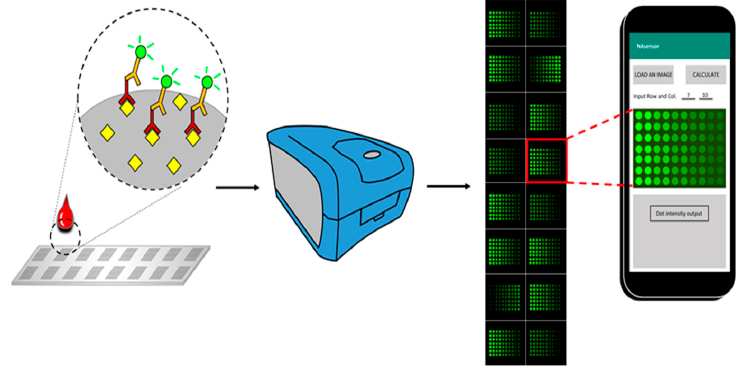
Figure 1. Schematic diagram of the smartphone-based imaging analysis for the fluorescent-labeled autoantibody array. Antigens were printed on the surface of an array slide, and the slide can be divided into multiple fields according to the printing design. A whole field contains hundreds of different antigen spots that are capable of detecting abundant types of corresponding autoantibodies in the serum, with each spot representing one type of antigen. Cy-3 labeled anti-human IgG was used to recognize the antigen-antibody complex, and an image was obtained through the fluorescent scanner from Molecular Devices. Subsequently, the image was then analyzed by the application in the smartphone, and data for each spot can be exported for further